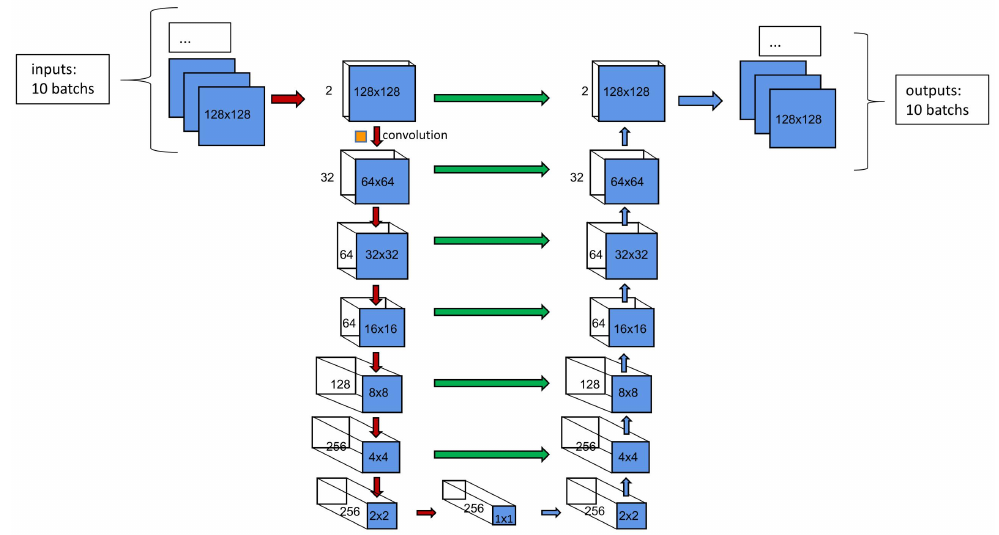
Figure 1. Schematic of the CNN architecture. Each blue box represents a multichannel feature map generated by the last convolutional layer. The generating matrix size is denoted in the box. Green arrows denote “skip-connections” via